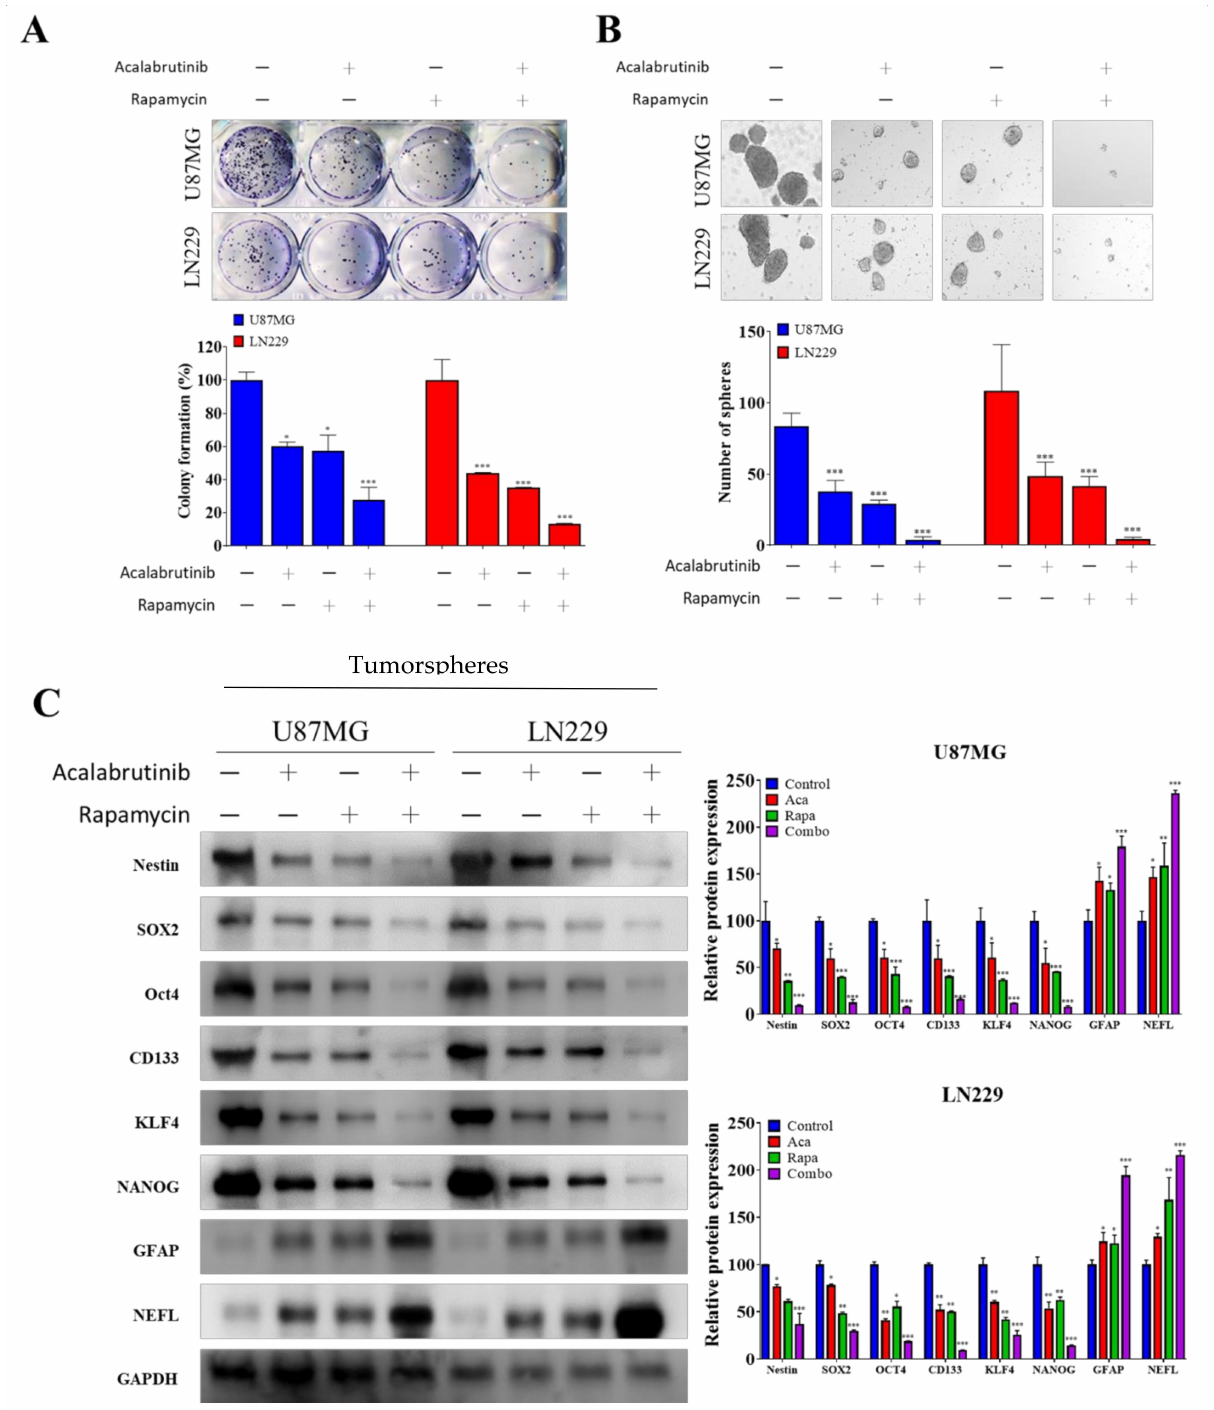
Figure 2. Acalabrutinib (5 µ M) and rapamycin (0.01 µ M) combination demonstrated enhanced efficacy in attenuating the tumorsphere-forming ability of GBM cell lines. To a greater extent than acalabrutinib or rapamycin treatment alone, the combination of acalabrutinib and rapamycin ( A ) strongly inhibited the colony-forming ability of GBM cell lines; ( B ) markedly inhibited the tumorsphere-forming ability of GBM cell lines; ( C ) Western blot assay of tumorspheres derived from U87 and LN229 cell lines revealed that the combination of acalabrutinib and rapamycin markedly attenuated the protein expression of CSCs markers Nestin, SOX2, OCT4, CD133, and KLF4, but upregulated differentiation markers GFAP and NEFL. * p < 0.05; ** p < 0.01; *** p <